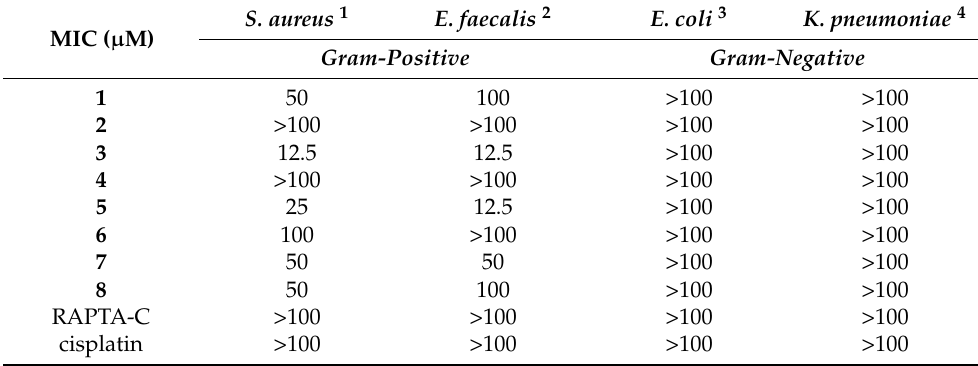
Table 2. Antibacterial activity of the complexes on Gram-positive and Gram-negative bacterial strains. MIC: minimum inhibitory concentration. MIC ( µ